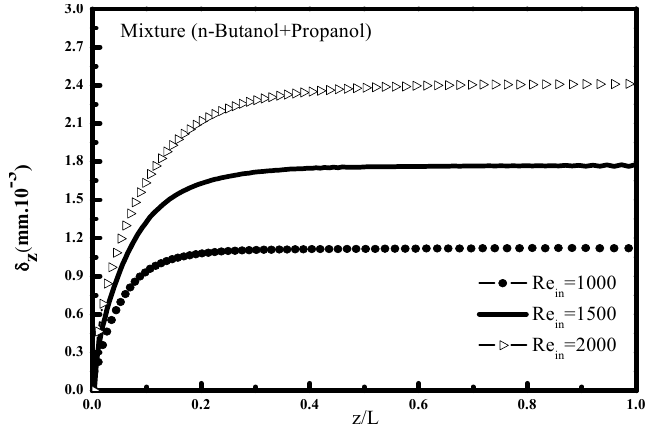
Figure 9. Variation of the bulk mass fraction the tube for different Re in .